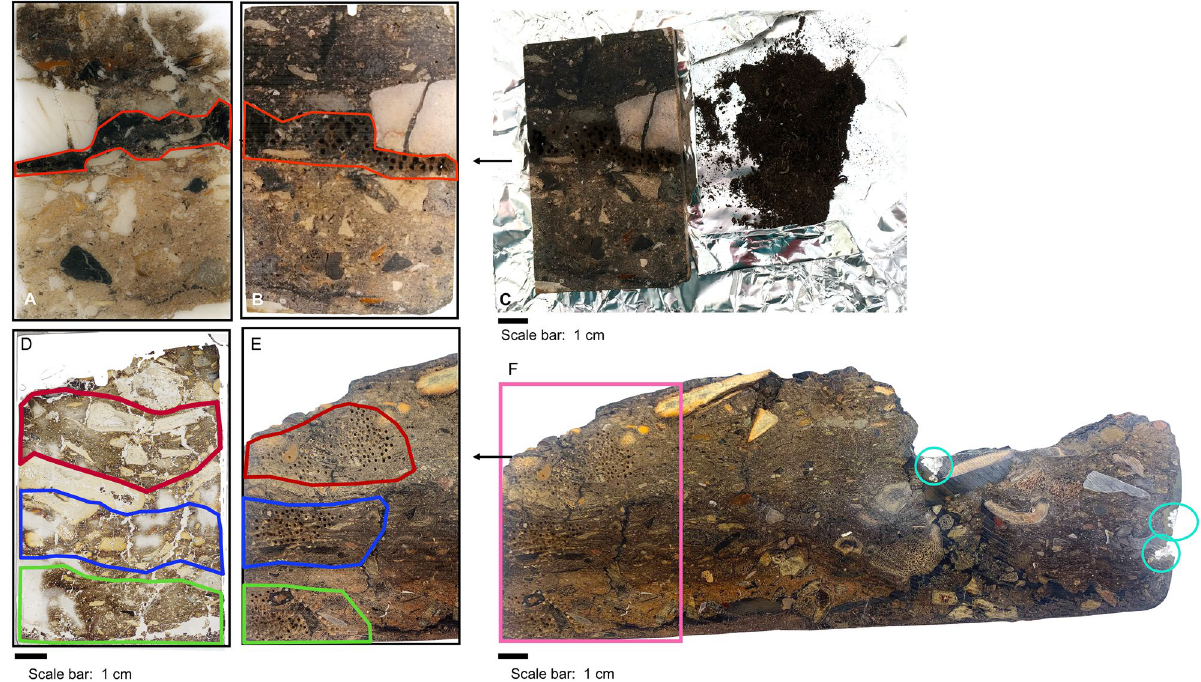
Figure 4. Example of drill dust collected from Salt-10-13 and Axlor slabs: ( A ) Flatbed scan image of a thin section from Salt-10-13 with area of interest outlined in red. ( B ) 1 cm-thick resin-impregnated slab of Salt-10- 13, which is the mirror image of ( A ) and ( C ) Drill dust (0.2 g) obtained from the drilling process. ( D ) Flatbed scan image of thin section from Axlor-18–1 with areas of interest outlined in red, blue and green. ( E ) 1 cm-thick resin-impregnated slab of Axlor-18-1 with drill marks and ( C ) Axlor-18-1 block with the drilling area outlined in pink and resin control areas circled in